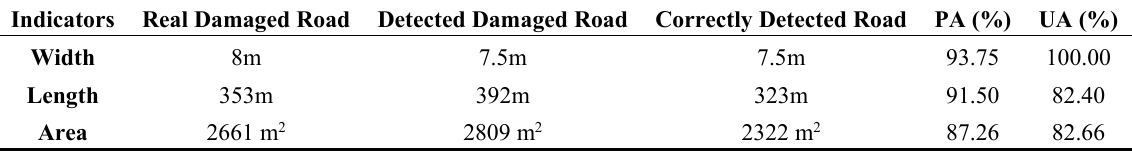
Table 2. Accuracy evaluation of road damage